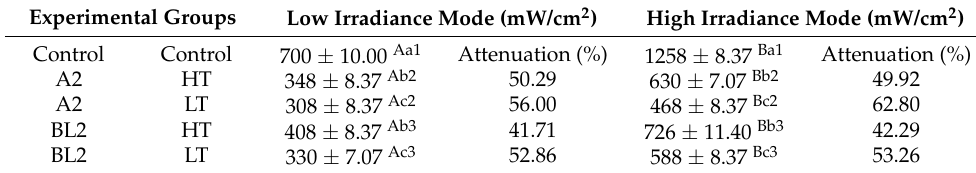
Table 1. Irradiance reaching the radiometer when ceramics with different opacity properties are interposed between light emitted by light-emitting diodes and the radiometer (mean ± SD). Experimental